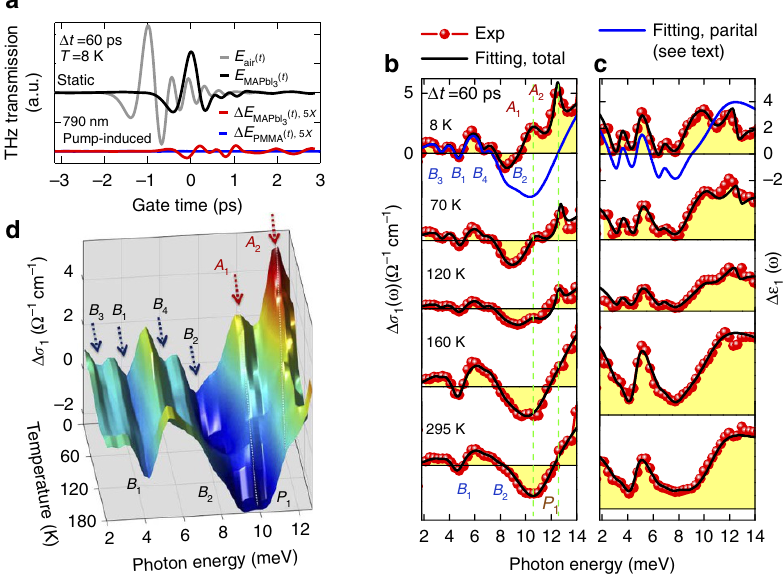
Figure 2 | The direct observation of excitonic Rydberg states in CH 3 NH 3 PbI 3 . ( a ) THz fields transmitted (raw data) through a clear aperture (grey), the sample without pump (black) and its pump-induced change (red) under 790nm wavelength and 550 m Jcm (cid:2) 2 fluence, at T ¼ 8K and pump probe delay D t ¼ 60ps. There is negligible pump-induced change for pure PMMA (blue). ( b , c ) Ultrafast THz spectra D s 1 ( o ) and D e 1 ( o ) under the same pumping conditions as ( a ) for various temperatures. This demonstrates the distinct resonant, internal quantum transitions, the 1 s - 2 p and 1 s - 3 p marked as A 1 and A 2 , which are clearly different from the phonon bleachings in the CH 3 NH 3 PbI 3 ( B j ¼ 1,..,4 ) and PMMA ( P k ¼ 1,2 ) (Supplementary Fig. 4 and Supplementary Note 4). Shown together are the complete (black lines) and partial (blue lines, without excitonic contribution) model calculations by equation (1). ( d ) A 3D view of the temperature-dependent D s 1 ( o ) spectra further confirms the fine details of the phonon bleaching